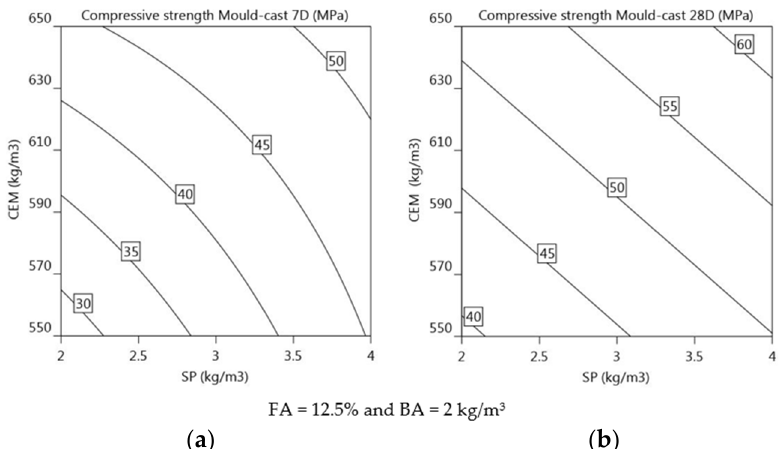
Figure 14. Isoresponse curves for compressive strength of mould ‐ cast members ( a ) CEM versus SP at 7 days; ( b ) CEM versus SP at 28 days.